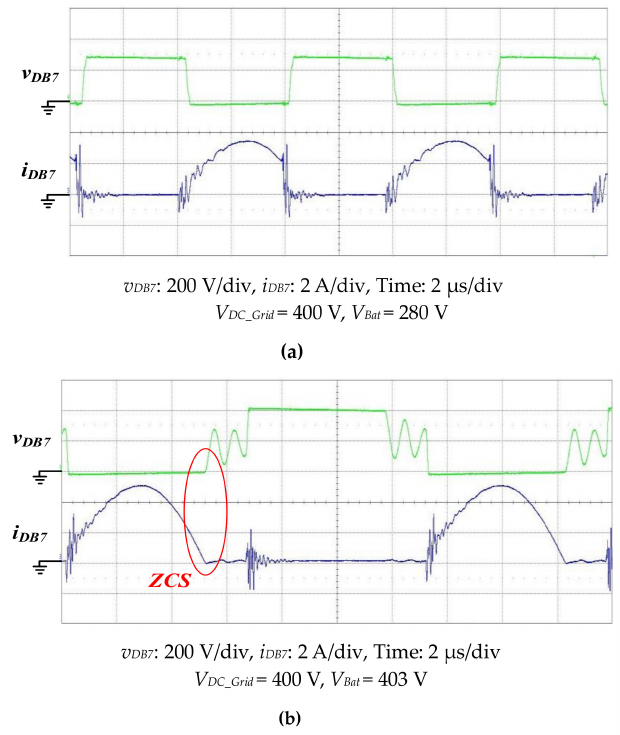
Figure 17. Waveforms of v DB7 and i DB7 with two battery voltages: ( a ) V Bat = 280 V; ( b ) V Bat = 403 V.